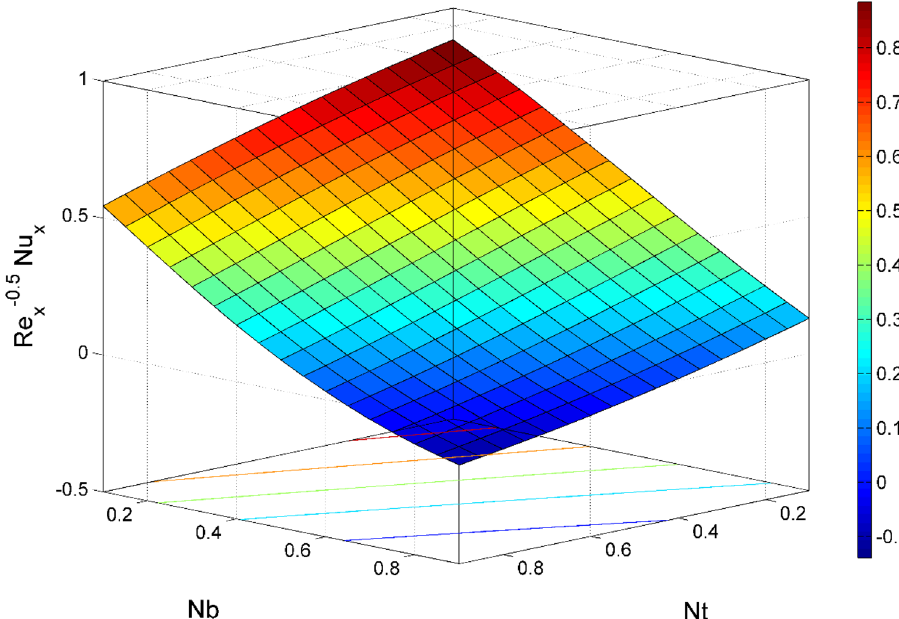
Figure 19. Re − 0.5 y Nu x behavior for the variation of Brownian motion Nb and Thermophoresis Nt .